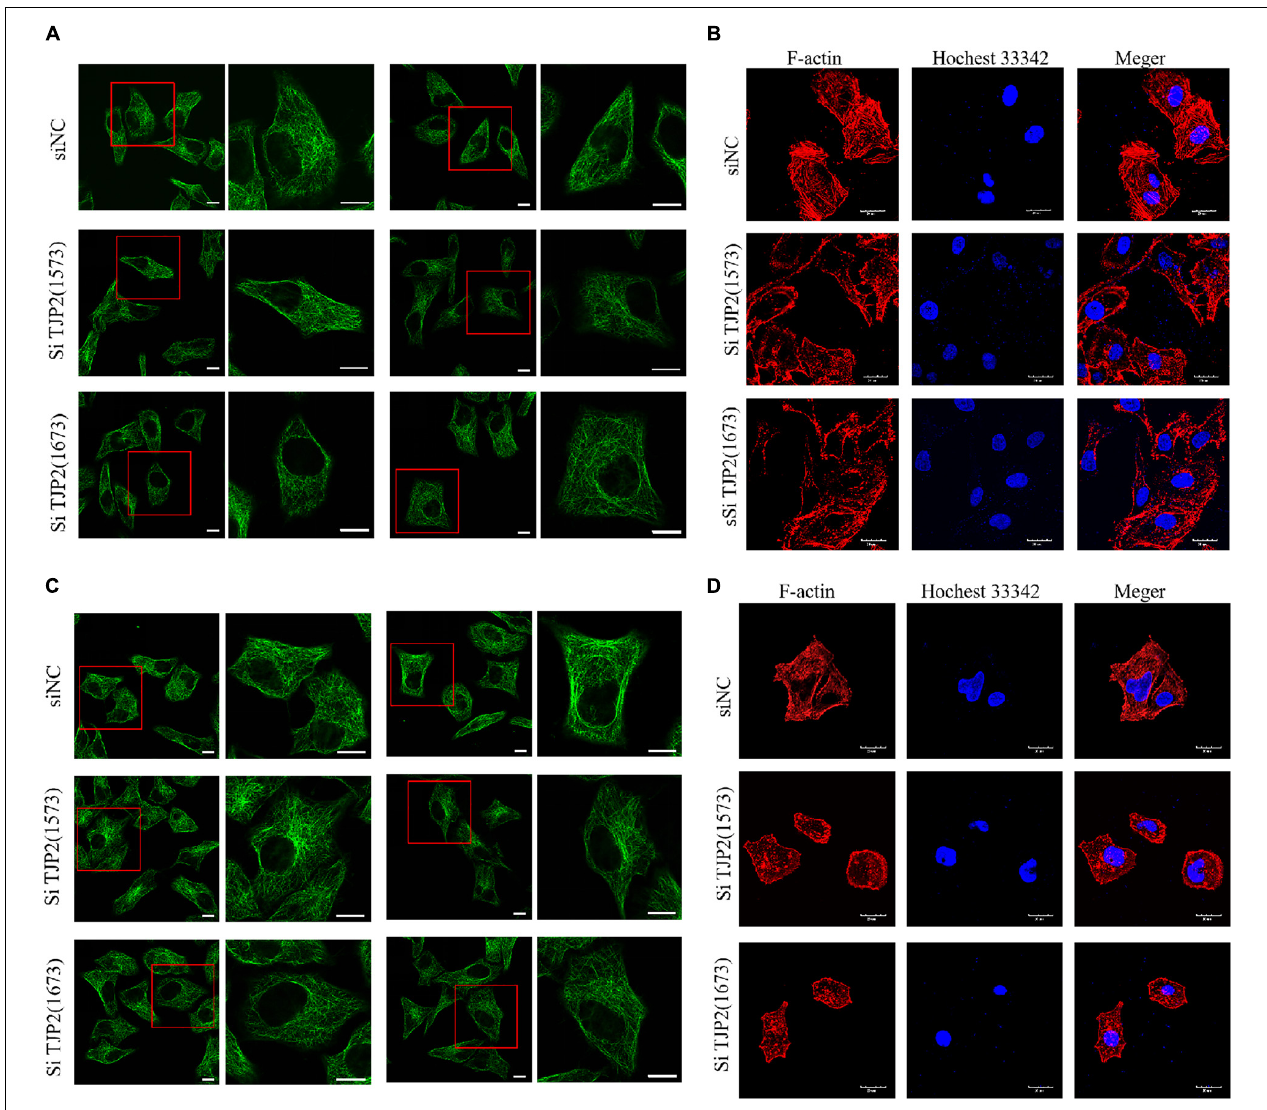
FIGURE 4 | The downregulation of TJP2 expression results in dispersed F-actin and disordered microfilaments. (A) No apparent change of microtubules was observed between the negative control group and siRNA-transfected groups in LO2 cells. siNT is the negative control group; siTJP2 (1573) and siTJP2 (1673) are treatment groups transfected with siRNA (1573) and siRNA (1673), respectively. The red box indicates microtubules labeled with green fluorescence. Microtubules in LO2 cells were visualized by confocal microscopy using an anti- β -tubulin antibody (Abcam, Cat. #ab195883). (B) The downregulation of TJP2 protein expression resulted in dispersed F-actin and disordered microfilaments in LO2 cells. F-actin (Cytoskeleton Inc., Cat. # PHDG1-A) was labeled with red fluorescence; the nucleus was labeled with blue fluorescence by hochest33342 staining. Merge represents the merged fluorescent image of F-actin and nucleus labeled by red and blue fluorescence. (C) No apparent change of microtubules was observed between the negative control group and siRNA-transfected groups in HepG2 cells. (D) The downregulation of TJP2 protein expression resulted in dispersed F-actin and disordered microfilaments in HepG2 cells. Scale bars, 20 µ